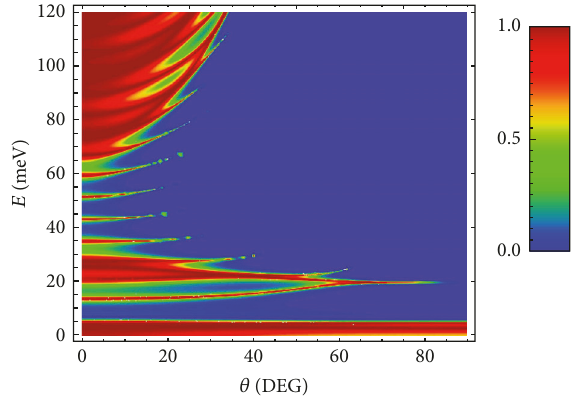
Figure 6: As in Figure 5 for spin-down electrons.